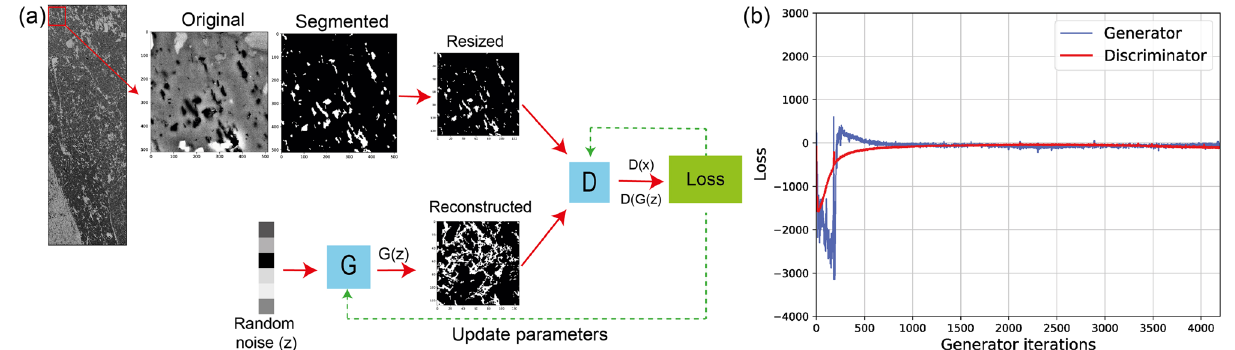
Figure 2. Training WGAN-GP with BSE images of the meta-igneous rock. ( a ) Schematic description of the general workflow. G and D are the generator and the discriminator with architectures described in Table S1. (section) Training dynamics of WGAN-GP show how two losses are converging around zero with generator iterations. In practice, the parameters of the discriminator were updated five times for each generator’s update. The same workflow was used for the reconstruction of the